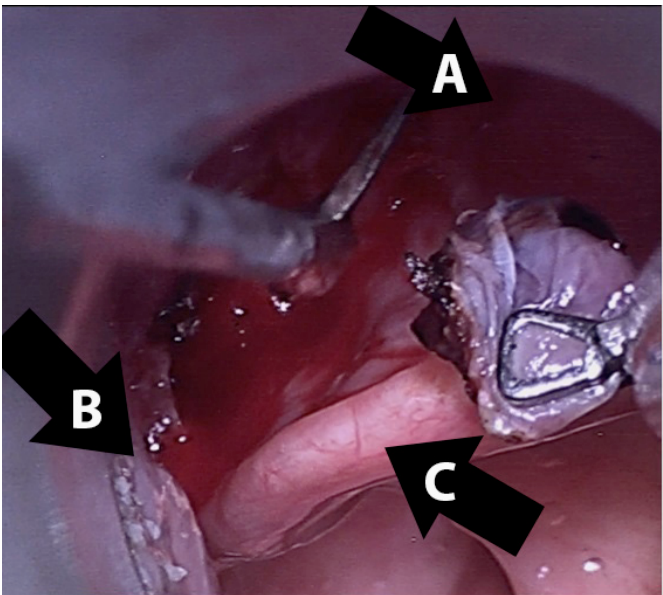
Figure 2. Extrication of varix. Extrication of varix at the base with Jako scissors after yttrium aluminum garnet laser cauterization. A) Tongue base. B) Lateral pharyngeal wall. C)